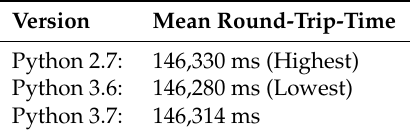
Table 4. Versions mean